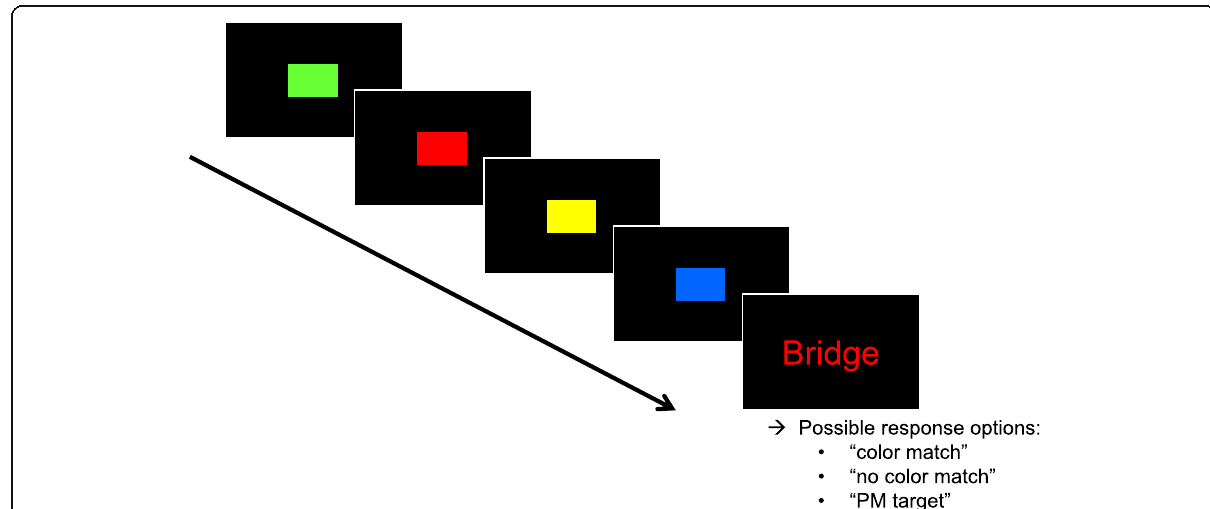
Fig. 1 Example trial of the prospective-memory (PM) task embedded in the ongoing color-matching task. Adapted by permission from R. E. Smith and R. R. Hunt (2012). Prospective Memory: Adult Age, Ongoing Task Difficulty, and Task Importance [Poster presentation]. Cognitive Aging Conference, Atlanta, GA, United